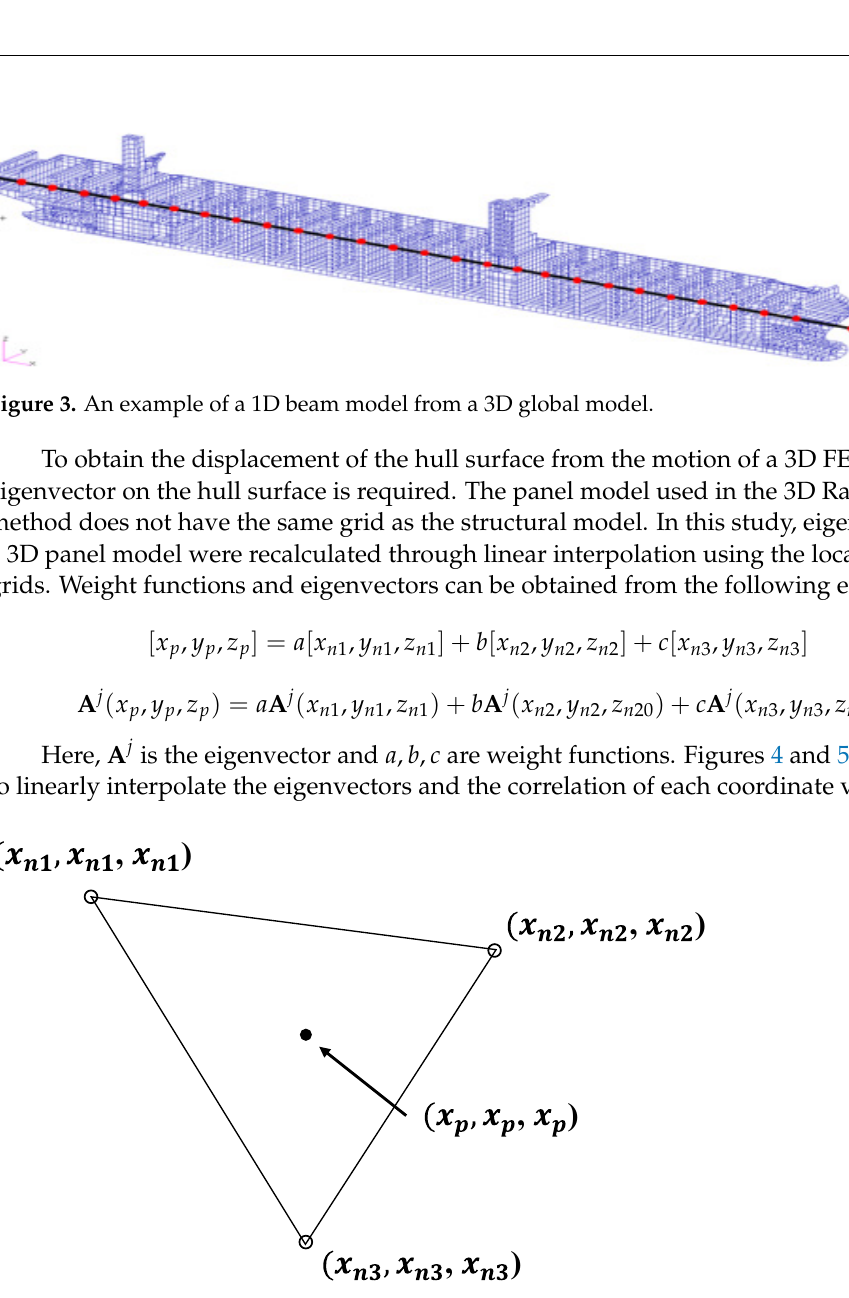
Figure 4. Calculation of weight function based on the positions.